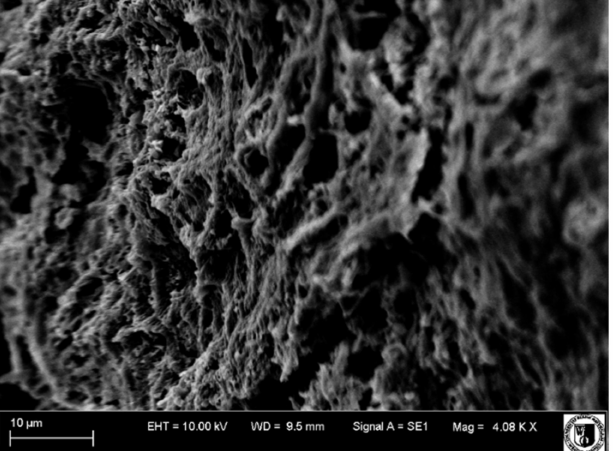
Figure 20. Scanning electron microscope image, human molar—Group II. Slightly damaged collagen fibres of the pulp run disorderly in different directions. 4000 ×